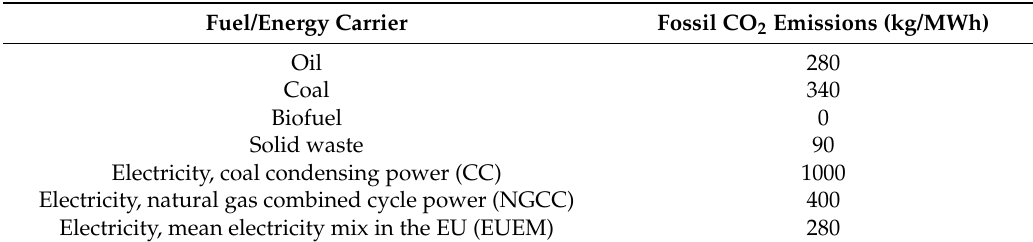
Table 4. The emission factors used for the different fuels and the different allocation methods for changes in electricity